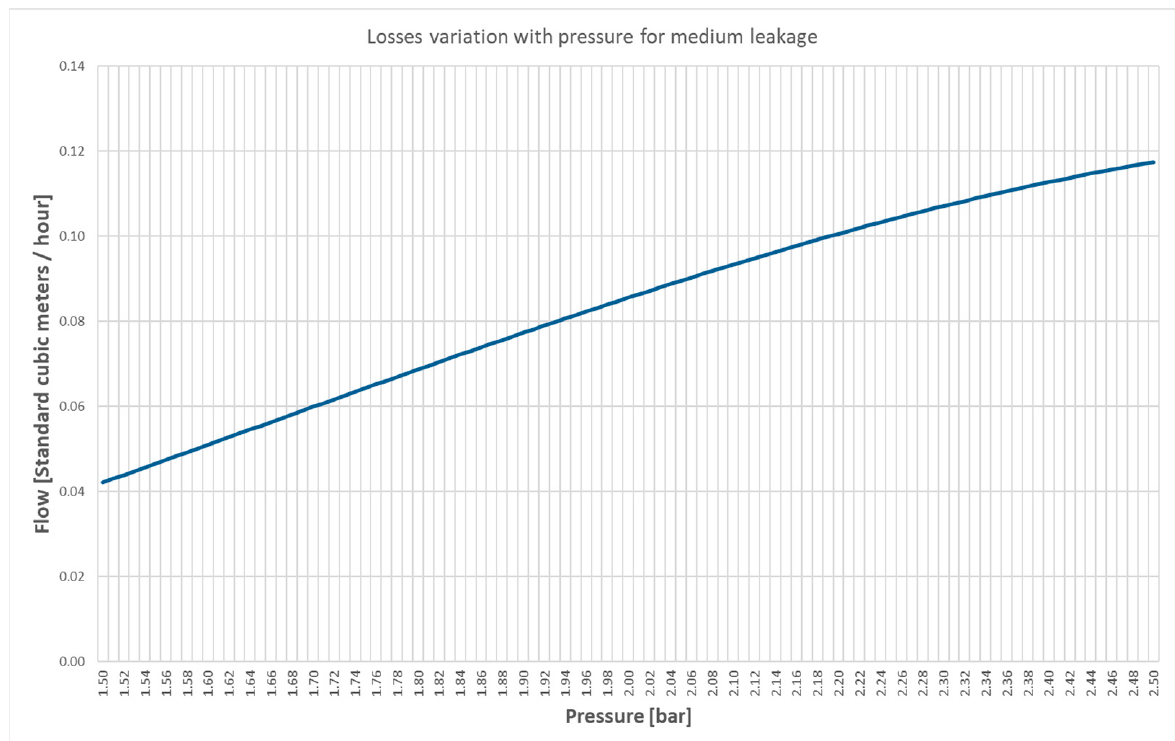
Figure 9. Variation in lost flow as a function of reduced pressure for medium faulty fitting (source: authors based on the analysed data).